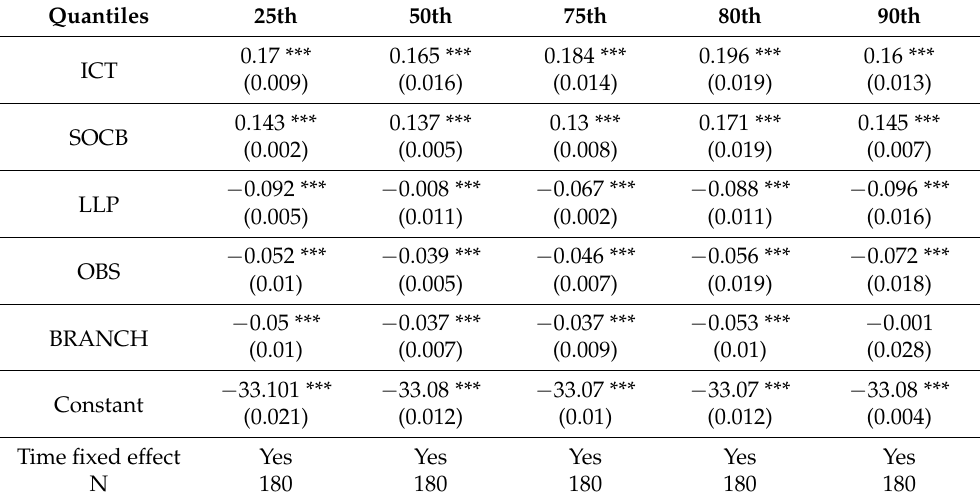
Table 3. The result of our baseline model (with EF as the dependent